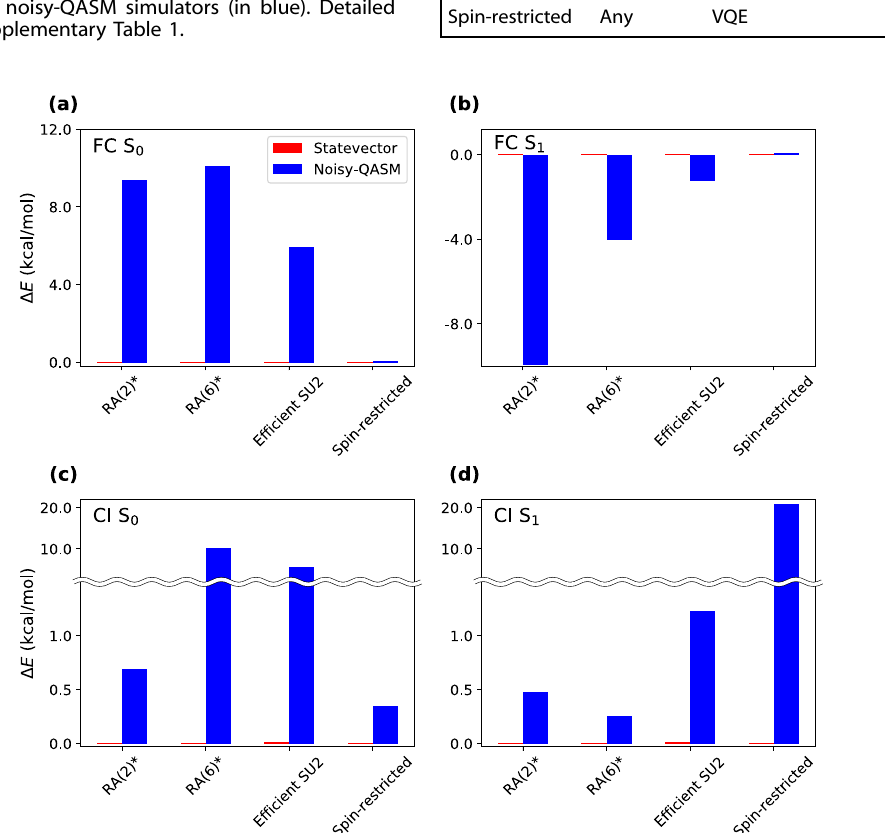
Fig. 5 Comparison of ansätze for the ground and excited state calculations of ethylene. Energy deviations Δ E (in kcal mol − 1 ) from the exact values for S 0 at the FC ( a ), S 1 at the FC ( b ), S 0 at the CI ( c ), and S 1 at the CI ( d ) were calculated using the SA-CASSCF method. The errors in energy obtained by the statevector and noisy-QASM simulators are shown in red and blue, respectively. The results labeled with an ‘ * ’ indicate that the maximum number of orbital rotations was reached. The parameters were β = 1 for all the ansätze, γ = 1 for the heuristic ansätze. Detailed values are shown in Supplementary Table